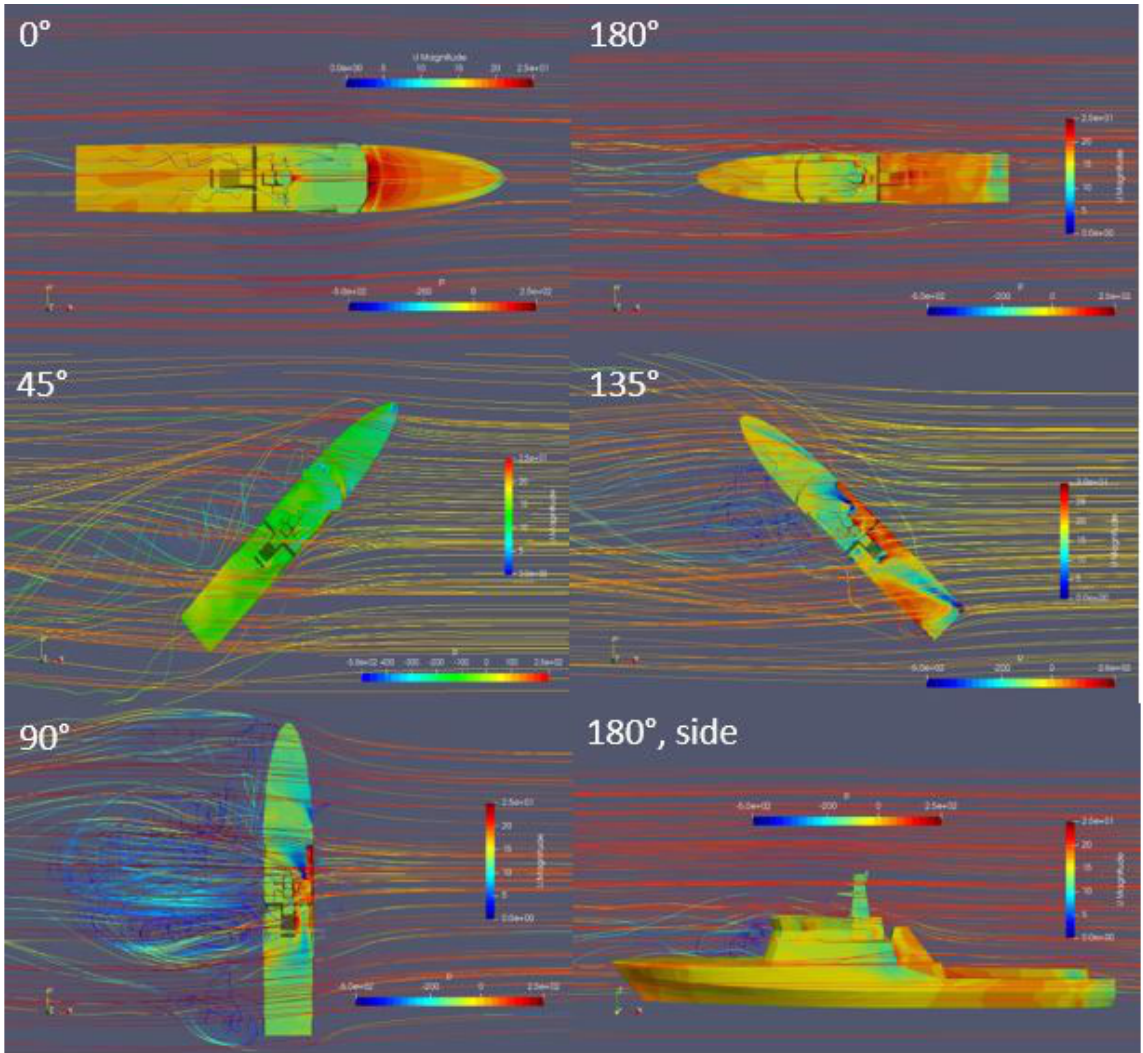
Figure 11. Velocity stream and pressure distribution on the full-scale hull form (above water part) while interacting with the wind at various angles (velocity scale: 0 to 25; Pr. scale: − 500 to 250), after reaching the steady-state.